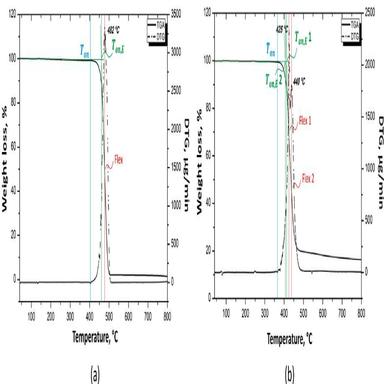
TGA curve (solid line) and DTG (dotted line) of HDPE (a) and PET (b).